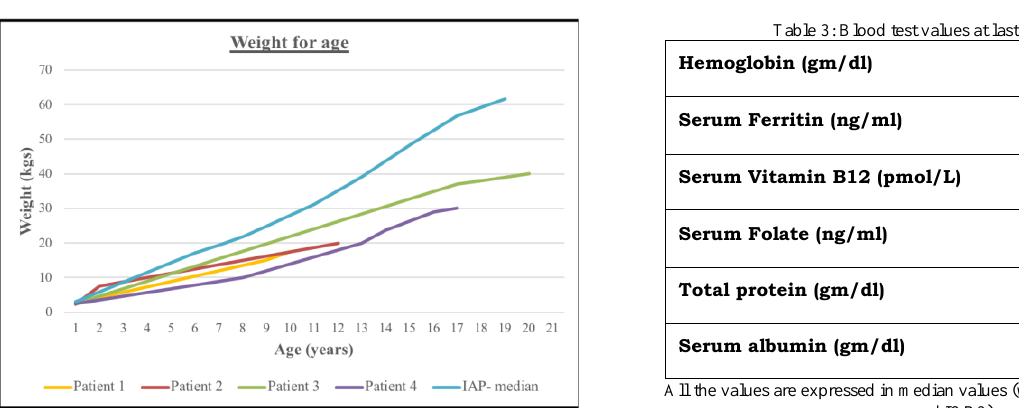
Figure 1: Weight for age plot of the children over follow-up period Table 2: Anthropometric data at last follow up visit Age (months)